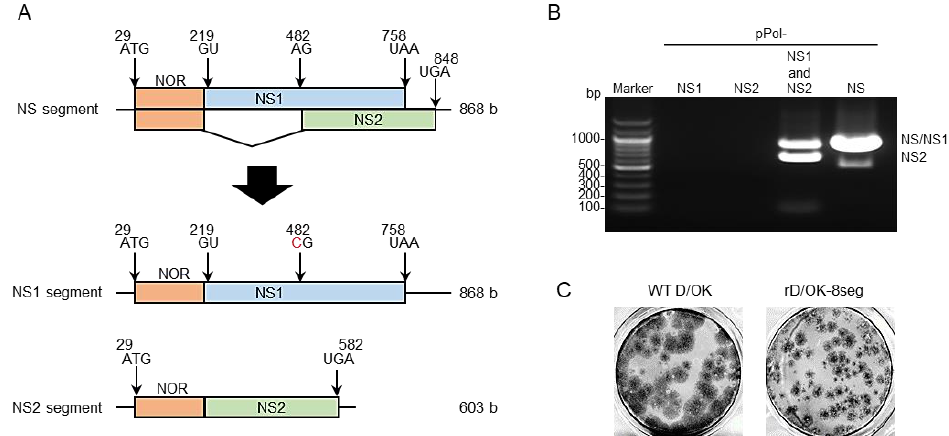
Figure 1. Generation of IDV with 8-segmented genome. ( A ) We created vRNA-synthesis pPol plasmids for monocistronic NS1 or NS2 segment by engineering the NS segment of D/swine/Oklahoma/1334/2011 (D/OK). N-terminal overlapping region (NOR) between NS1 and NS2 genes, NS1-, and NS2-specific regions are shown in orange, blue, and green, respectively. Each number indicates the nucleotide position and the red letter indicates the substituted nucleotide. ( B ) vRNA-synthesis pPol plasmids for NS1 and/or NS2, or NS segments were co-transfected with the other 6 (PB2, PB1, P3, HEF, NP, and M) segment vRNA-synthesis plasmids and 4 protein (PB2, PB1, P3, and NP)-expression plasmids into HEK293T cells. Thereafter, the supernatant was inoculated into ST cells. CPE was observed on ST cells following inoculation of the transfectant with pPol- D/OK-NS1 and -NS2 as well as pPol-D/OK-NS, but not with pPol- D/OK-NS1 or -NS2. Both NS1 and NS2 were detected by RT-PCR in the supernatant (rD/OK-8seg) of ST cells with 1% agarose gel electrophoresis. ( C ) Representative plaque morphologies of wild type (WT) D/OK and rD/OK-8seg in ST cells are shown by immunostaining with anti-D/OK mouse polyclonal antibody. Table 1. Generation of the rD/OK-8seg and its mutant. Virus segments